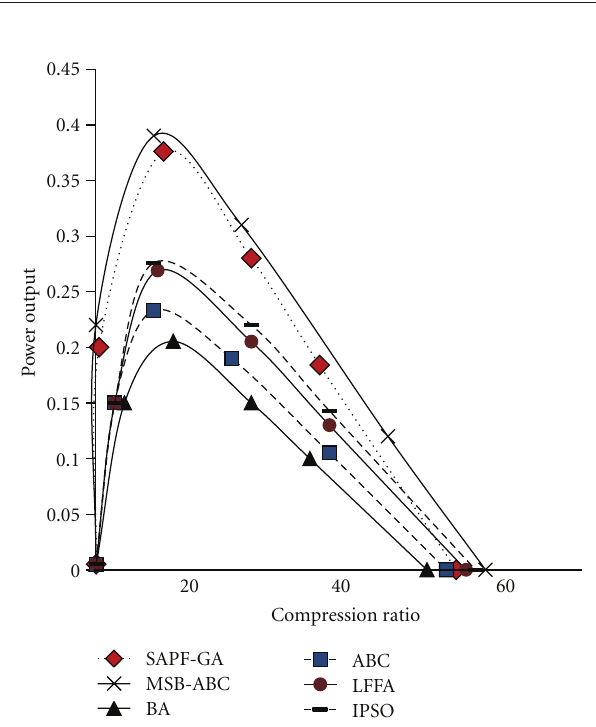
Figure 4: Performance of tested algorithm in γ 0 = 1 . 31 and k 1 = 0 .